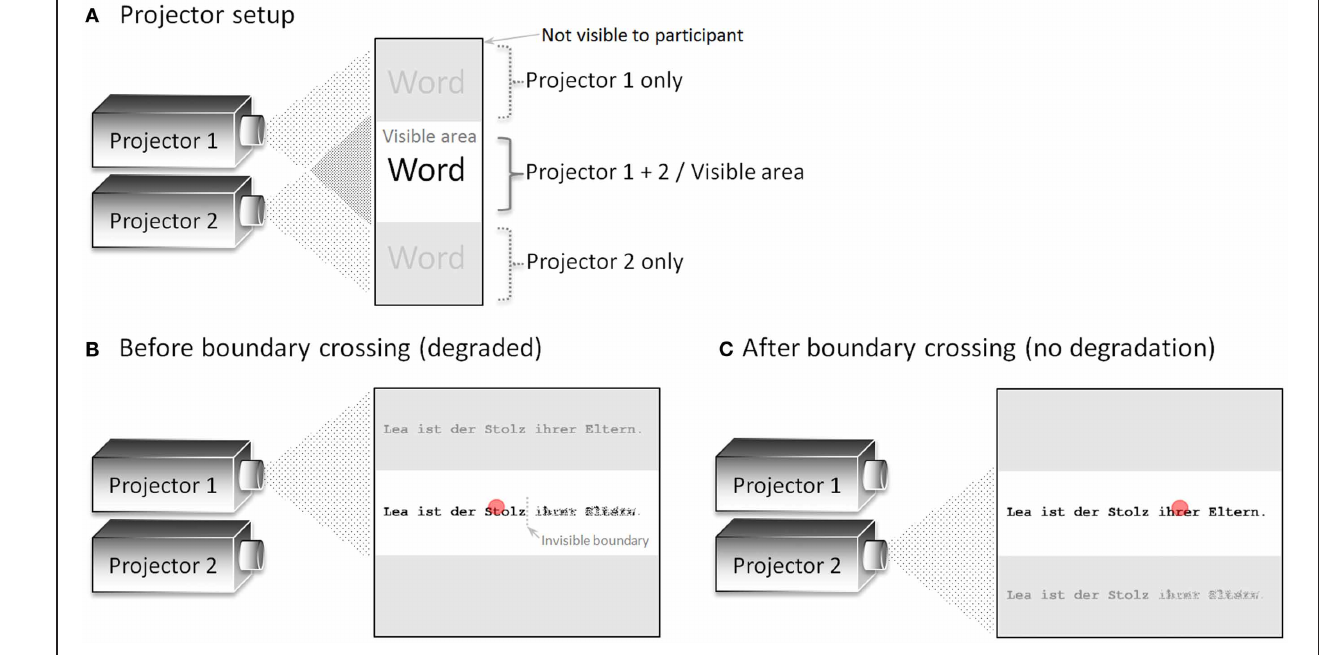
FIGURE 1 | (A) Schematic depiction of the projector setup in general. Here, both projectors (placed behind a semi-transparent screen) are switched on to visualize the projection areas. (B) Presentation before the invisible boundary was crossed. Only the lower part of the display (containing the degraded sentence on the right-hand side of